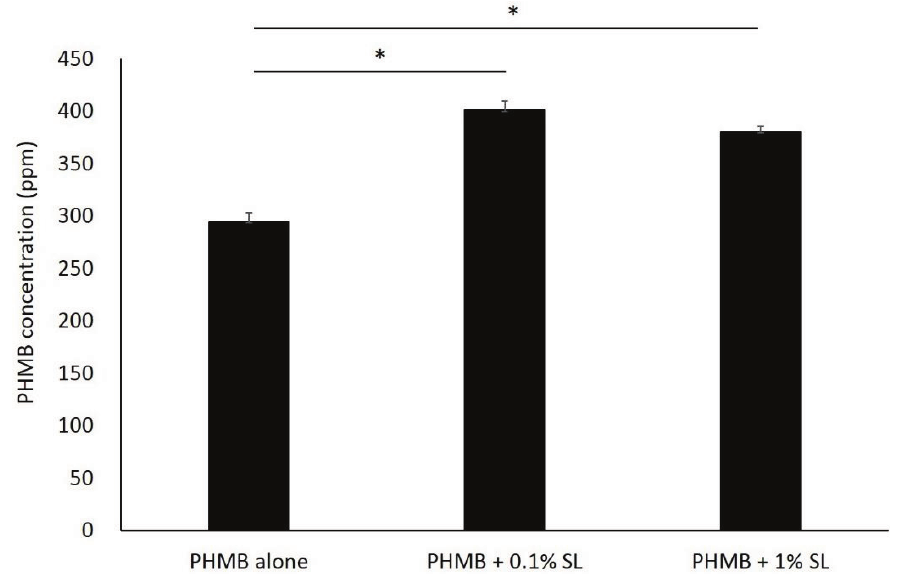
no significant difference between the non-woven textiles with PHMB and the soap washing group. There were no adverse events reported. Figure 1. Permeability of polyhexamethylene biguanide (PHMB) into stratum corneum. Permeability was assessed using a cultured skin model. PHMB was added to the culture medium with a final concentration of 0.1%, with 0.1 and 1% of sophorolipid, then incubated for 120 min. Inner stratum corneum PHMB concentration was quantified via polyvinylsulphuric acid potassium salt titration. Data represent mean with SD ( n = 3). * p < 0.001.